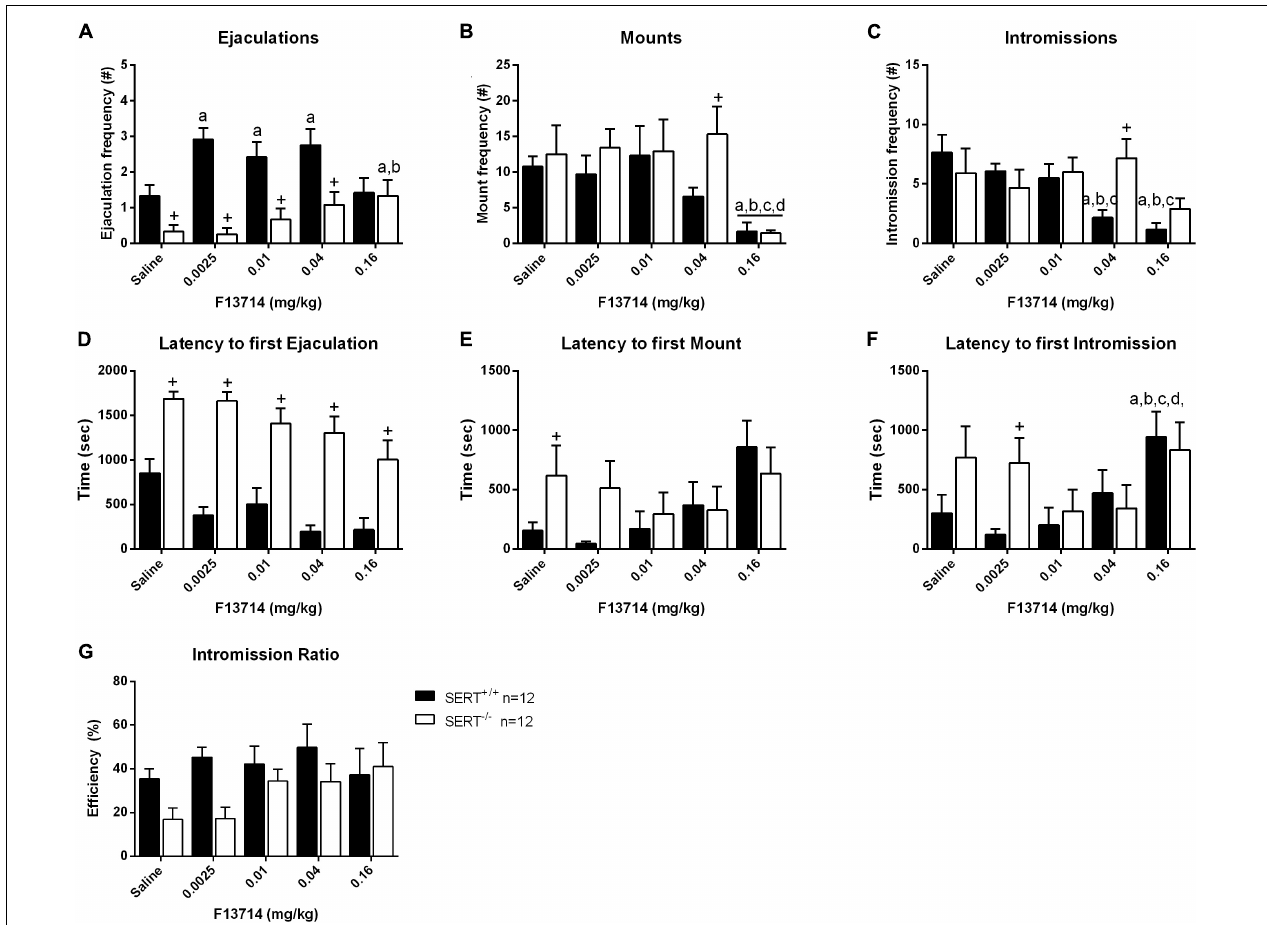
FIGURE 4 | Sexual behavior of male rats treated with 0, 0.0025, 0.01, 0.04, or 0.16 mg/kg F13714. The number and latency of ejaculations per 30 min (A,D) , number and latency of Mounts (B,E) , number and latency of Intromissions (C,F) , and Intromission Ratio (G) of the first Ejaculation Series are provided. Detailed statistical analyses are displayed in Supplementary Table 2 . a: significant difference ( p < 0.05) compared to saline group, b: significant difference ( p < 0.05) compared to 0.0025mg/kg group, c: significant difference ( p < 0.05) compared to 0.01/mg/kg group. +Significant difference between SERT + / + and SERT − / − ( p <